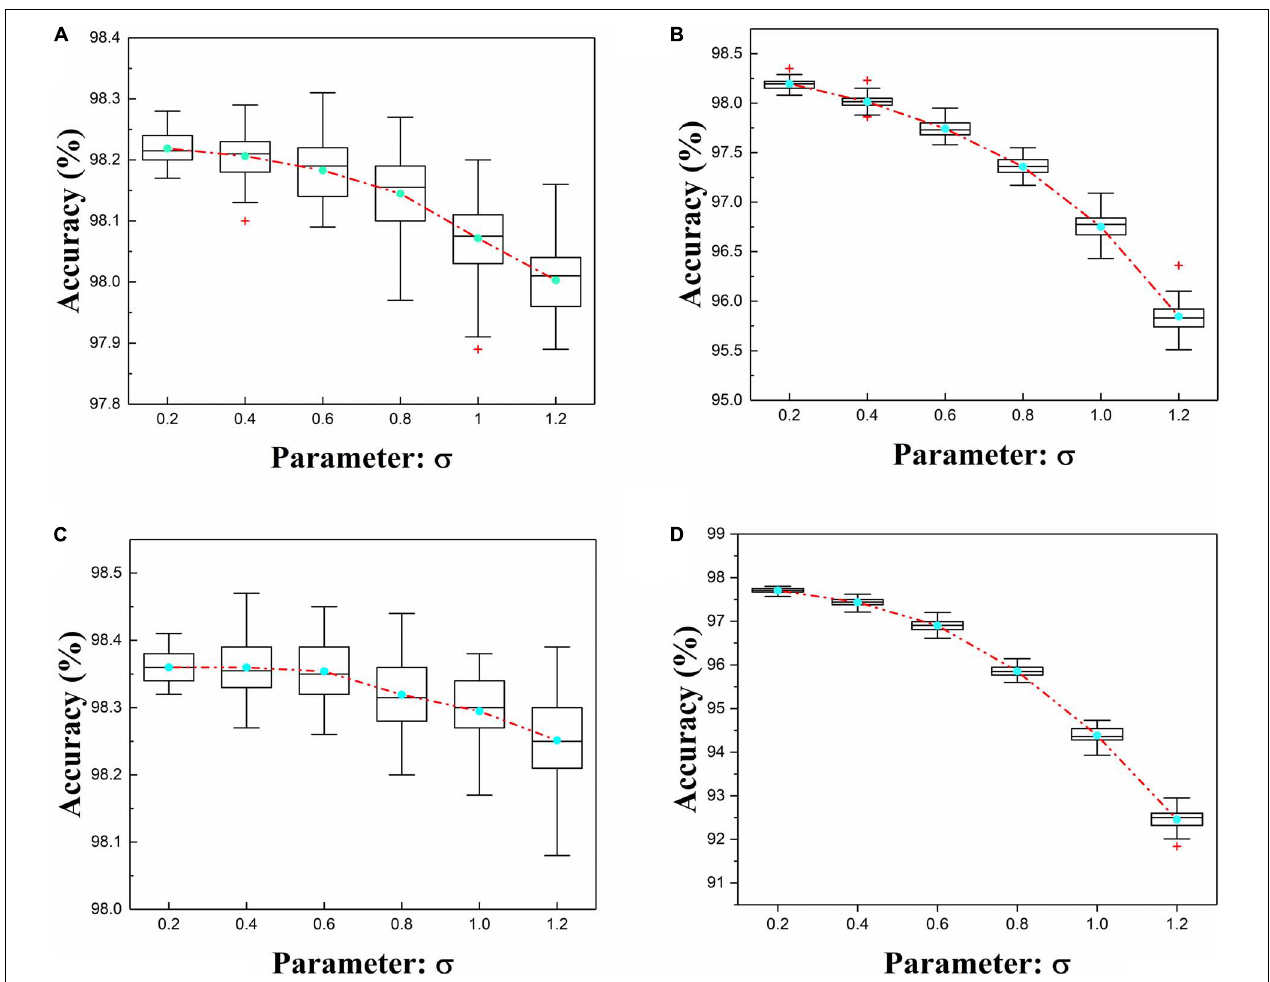
FIGURE 10 | Neuron output variation analysis results of ± 1 MD (left, A ) and 4-bit- ± 1 MD (bottom left, C ) or 01 MD (right, B ) and 4-bit-01 MD (bottom right, D ), and each box corresponds to 50 experiment